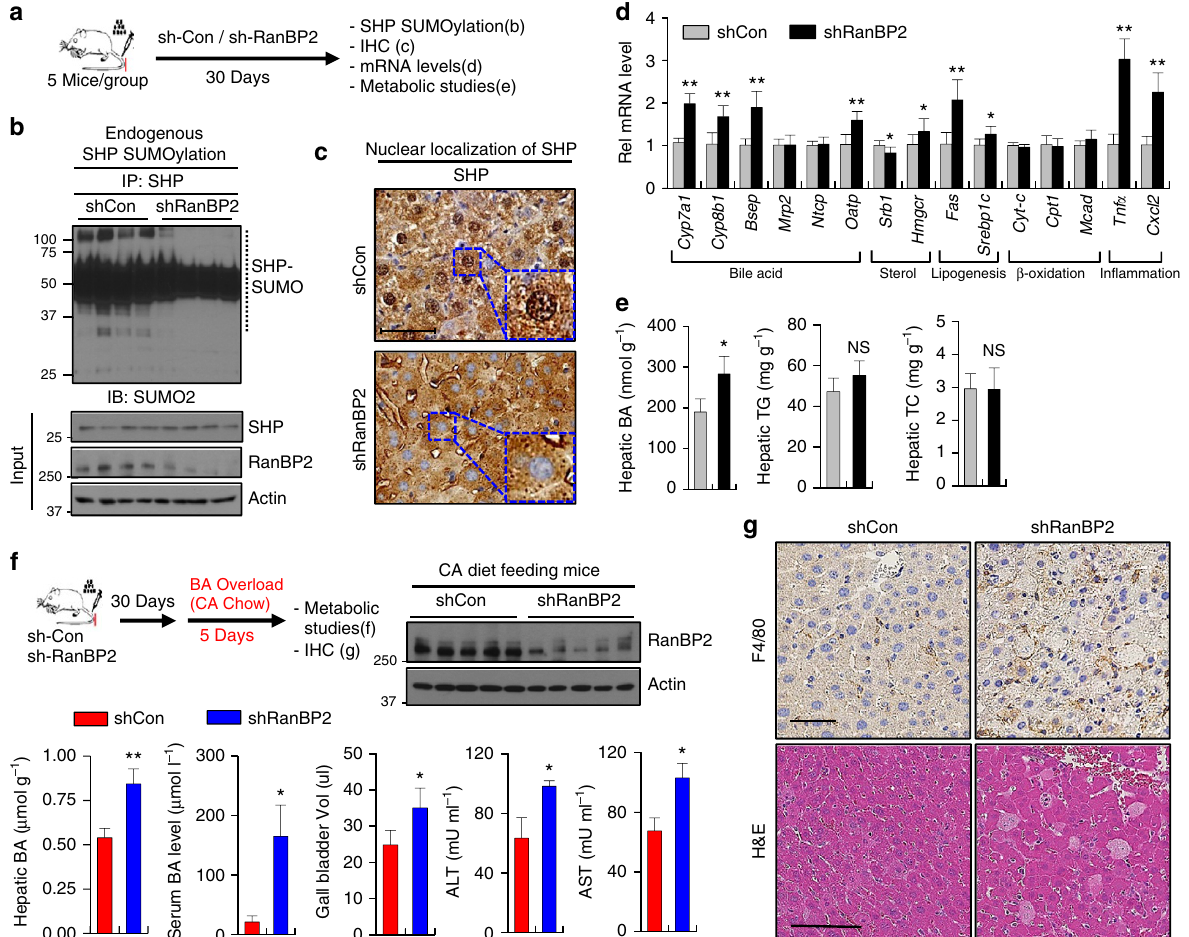
Figure 7 | Effects of downregulation of RanBP2 in BA regulation in mice. ( a – d ) Experiments without biliary insults. ( a ) Experimental Outline. ( b ) In vivo SUMO assay: SUMO-SHP levels in RanBP2-downregulated mice were detected by IP/IB. Endogenous SHP in liver extracts was immunoprecipitated with SHP antibody and SUMOylated SHP in the immunoprecipitates was detected by IB using SUMO2 antibody. Levels of RanBP2 or SHP in liver extracts after expression of control or RanBP2 shRNA were detected by IB. ( c ) Effects of downregulation of RanBP2 on subcellular localization of SHP in the mouse liver. SHP was detected by IHC. Scale bar, 50 m m. Effects on expression of the indicated genes ( d ) or the levels of BA, TG, and cholesterol ( e ) in the liver. In e , values for the control shRNA groups are set to 1. ( f , g ) Experiments with a biliary insult by BA overload. ( f ) Experimental outline and protein levels of RanBP2 detected by IB (top). The volume of the gall bladder, serum BA levels, liver BA levels, and serum ALTand AST levels were determined. BA levels are expressed per g of liver wet weight. Values represent mean ± s.e.m. Statistical significance was determined by the Student’s t -test, ( n ¼ 5 mice, * P o 0.05, ** P o 0.005, and NS, statistically not significant) ( d – f ). ( g ) Liver sections were stained with haematoxylin and eosin (H&E) to detect necrosis and macrophages were detected (brown) with F4/80 antibody. Scale bar, 100 m